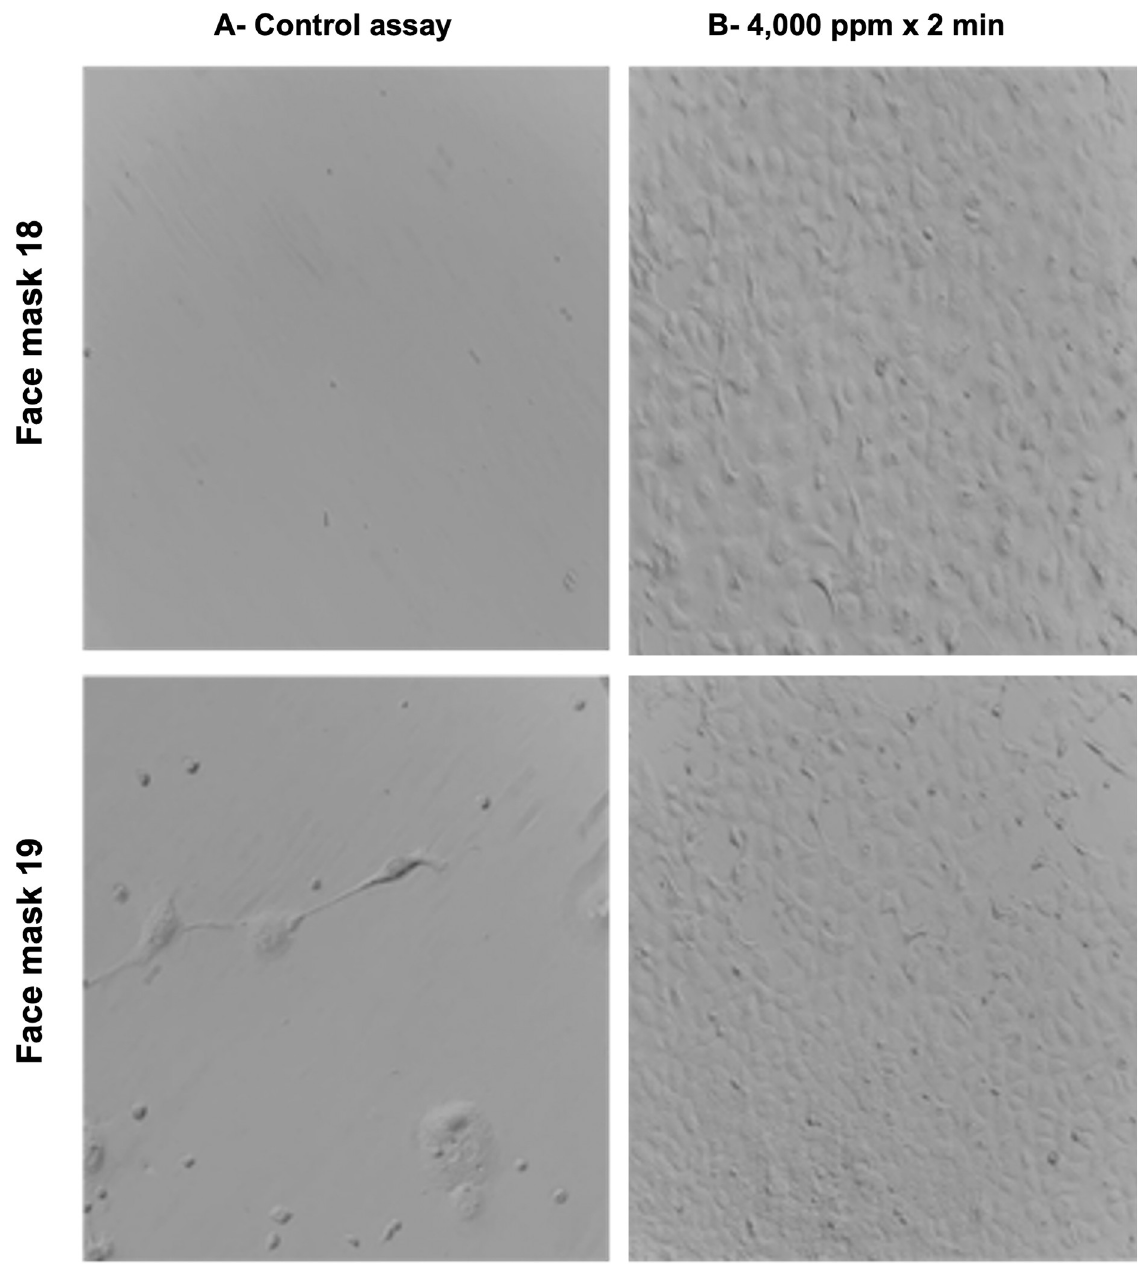
Fig 2. Representative images of VERO cells monolayer (x 20) after 48 h of incubation of VERO cell culture of face masks 18 and 19 from patients analyzed in the validation phase. Left: The positive control consisted of VERO cells infected with human coronavirus 229E ATCC 1 VR-740 ™ strain, which were completely lysed. Right: face masks 18 (upper) and 19 (lower) that were treated with ozone at 4,000 ppm for 2 min, showed no cytopathic effect (no viability of SARS-CoV-2). Experiments were performed in triplicate. https://doi.org/10.1371/journal.pone.0271826.g002 1 min, and 2,000 ppm for 5 min, resulting in 4,000 ppm for 2 min the best combination, which was validated in the second phase. It is worth mentioning that the ozone “concentration and time of exposure” conditions used in this study to inactivate natural SARS-CoV-2 in face masks are the same as we described for viral RNA elimination using a heat-inactivated